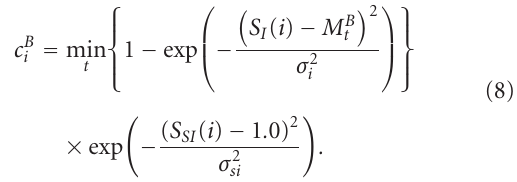
Figure 15: Comparison of pixel-based and superpixel-based graph cut algorithms on three di ff erent types of nodules. For each nodule in (a), (b), and (c), the first row shows the 3D nodule in the original CT subimages; the second row shows segmentation results based on the pixel-based method, and the last row shows results using the proposed superpixel based method.